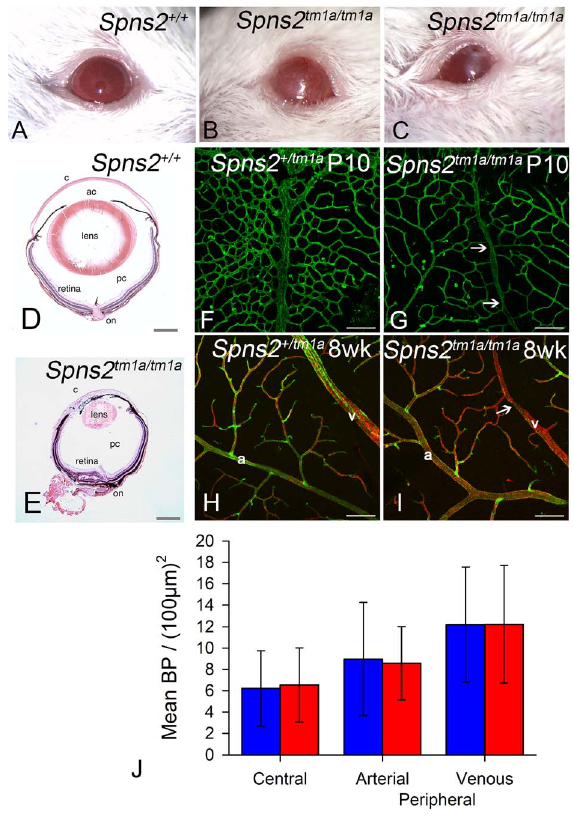
Figure 12. Eye defects in Spns2 tm1a/tm1a mice. A–C , Phenotype screening was performed on 15 week old Spns2 tm1a/tm1a mice and identified buphthalmos, corneal opacity with vascularization and possible ulceration ( B ) and corneal opacity with vascularisation and polyp, thick discharge, elongated pupil which did not fully dilate with tropicamide ( C ). Albino mice were selected to achieve